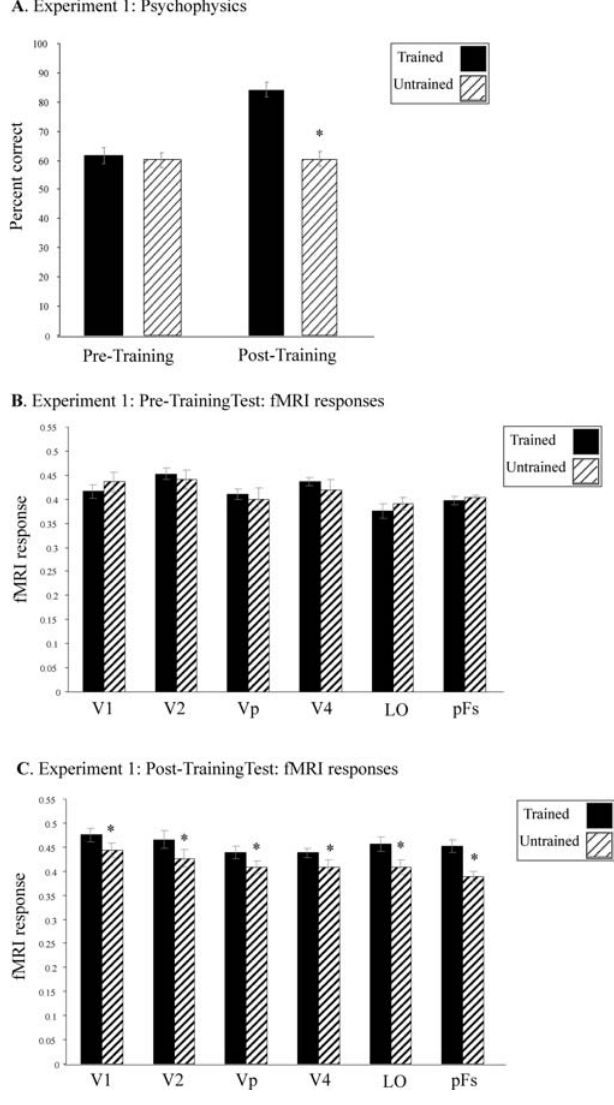
Figure 3. Results for Experiment 1 Psychophysical data (A) and fMRI responses obtained during the scanning sessions before (B) and after (C) training. Error bars indicate the SEM across subjects. Significant differences are indicated by asterisks. (A) Psychophysical data (percent correct) are shown for trained and untrained shapes in the tests before and after training. Normalized fMRI responses across subjects for trained and untrained shapes before (B) and after (C) training across the LOC subregions and the early ventral areas. Normalized fMRI responses were computed by subtracting the mean signal (percent signal change from fixation baseline) across conditions, sessions, and ROIs from the signal in each condition per subject and adding the overall average across conditions, sessions, ROIs, and subjects. These normalized fMRI responses indicate differences across conditions independent of the variability in the fMRI signal across subjects, scanning sessions, and